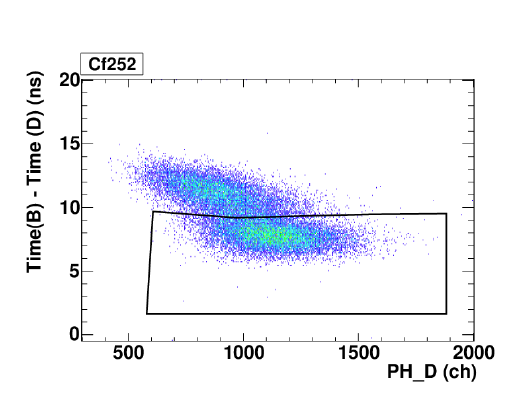
Figure 4. Time di ↵ erence for FF between PPACs B and D ver- sus the pulse height of the signal in PPAC D. The black contour selects the light fission